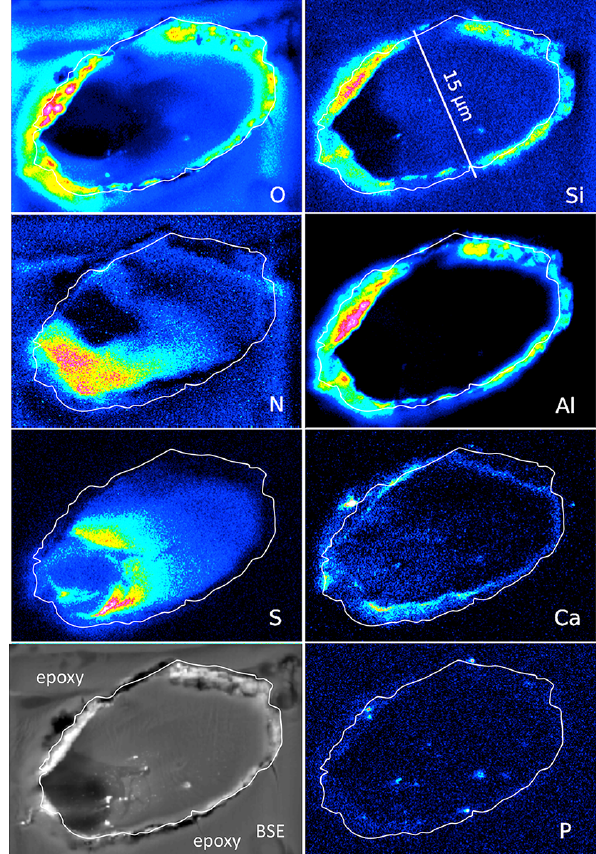
Figure 8. Element distribution (EMPA) of an oblique section of a 15µm wide filament embedded in epoxy. White line indicates out- ermost rim of the filament, as seen in the BSE image. BSE contrast is lowest in the area of low O and high N content. Si and Al (with O) form an outer rim, indicating Al silicates (probably clay miner- als, as determined by SEM). Ca is also concentrated in the rim but also in spots, together with P, and in the area with high S. Scanning conditions: pixel resolution of 360 × 265, pixel size of 80nm, dwell time per pixel of 200ms, total scan area 28 . 8µm × 21 .